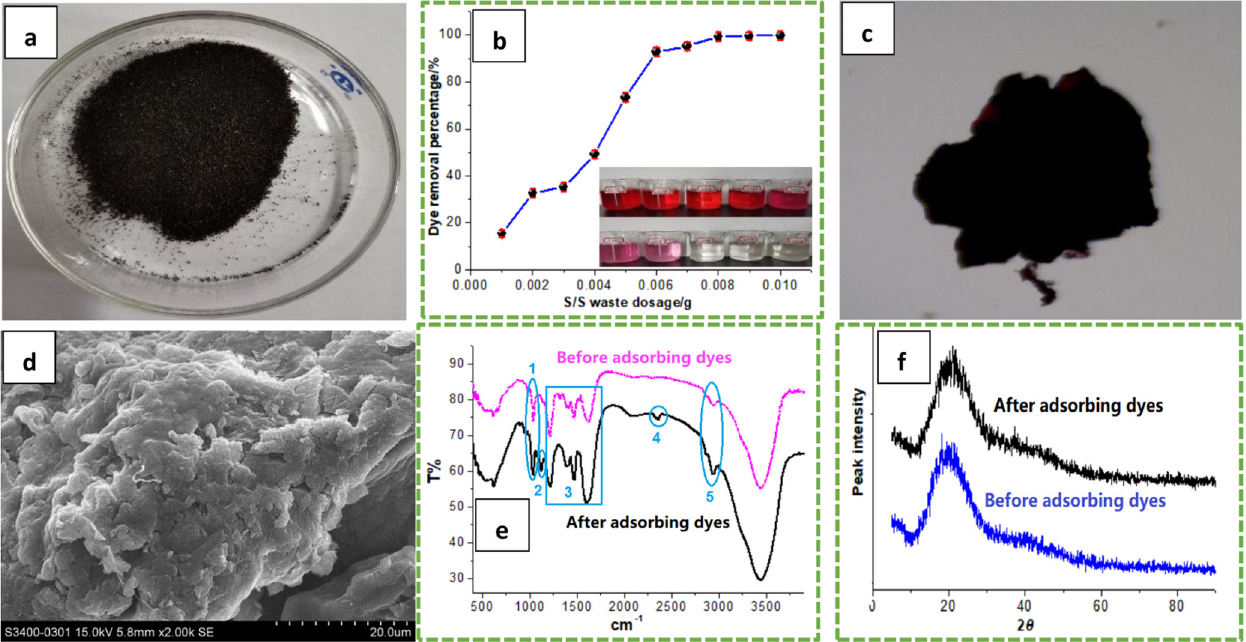
Fig. 7 Resourceful reuse behaviors of wastes from SGPQG/SGPQ treatment with lignins. a The original photos of S/S wastes. b The adsorption results of S/S wastes towards the dyes of Reactive Scarlet 3BS. c Optical microscope observation of the S/S wastes after adsorbing lignins in water. d SEM analysis of S/S wastes after adsorbing lignins. e Comparing FT-IR analysis of S/S wastes before and after adsorbing dyes. f Comparing XRD analysis of S/S wastes before and after adsorbing